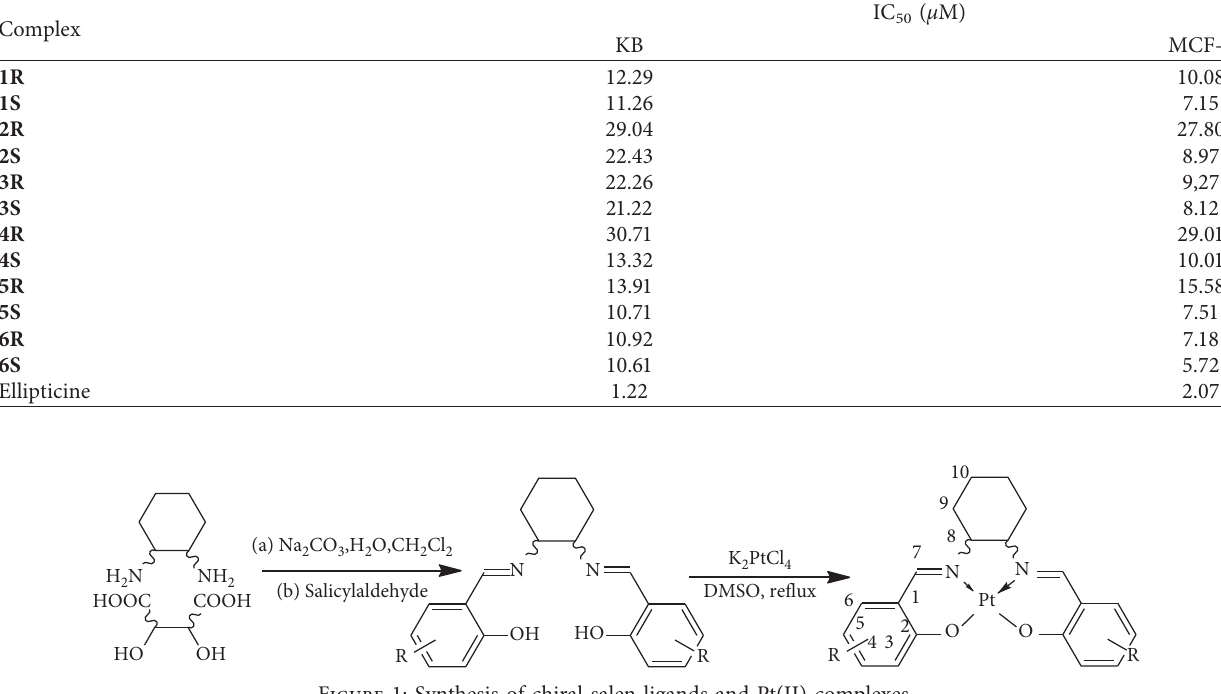
Table 2: The cytotoxicity of chiral Pt(II) complexes in vitro .